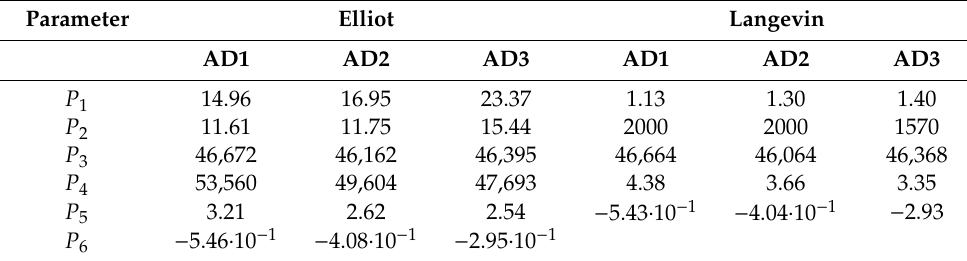
Table 19. Calculated parameters of the Alnico decreasing curves.